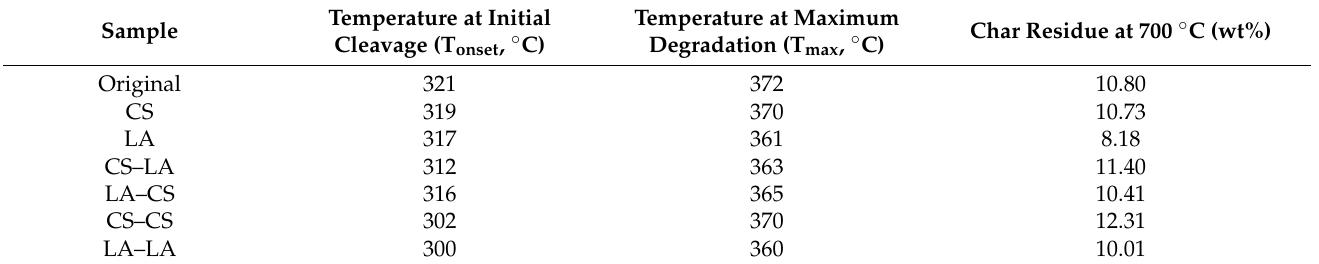
Figure 3. ( a ) TG thermograms and ( b ) DTG curves of original and mercerized cotton fabrics. Table 3. TG and DTG data for original and mercerized cotton fabrics.